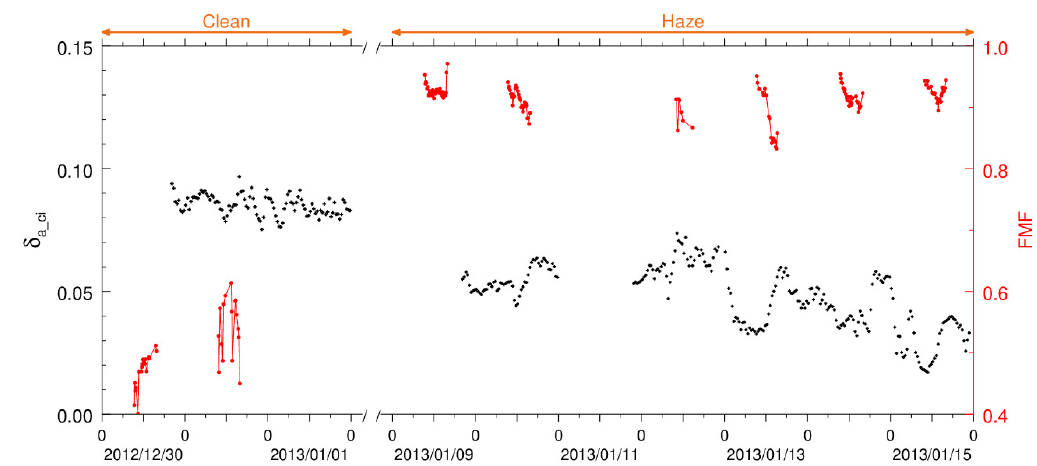
Figure 6. Time series of the fine mode fraction (FMF) from sun photometer measurements and the integrated particle depolarization ratio ( δ a_ci ) inferred from the lidar during the entire period. Aerosols were featured by weak depolarization and the predominance of fine mode particles during the haze period.